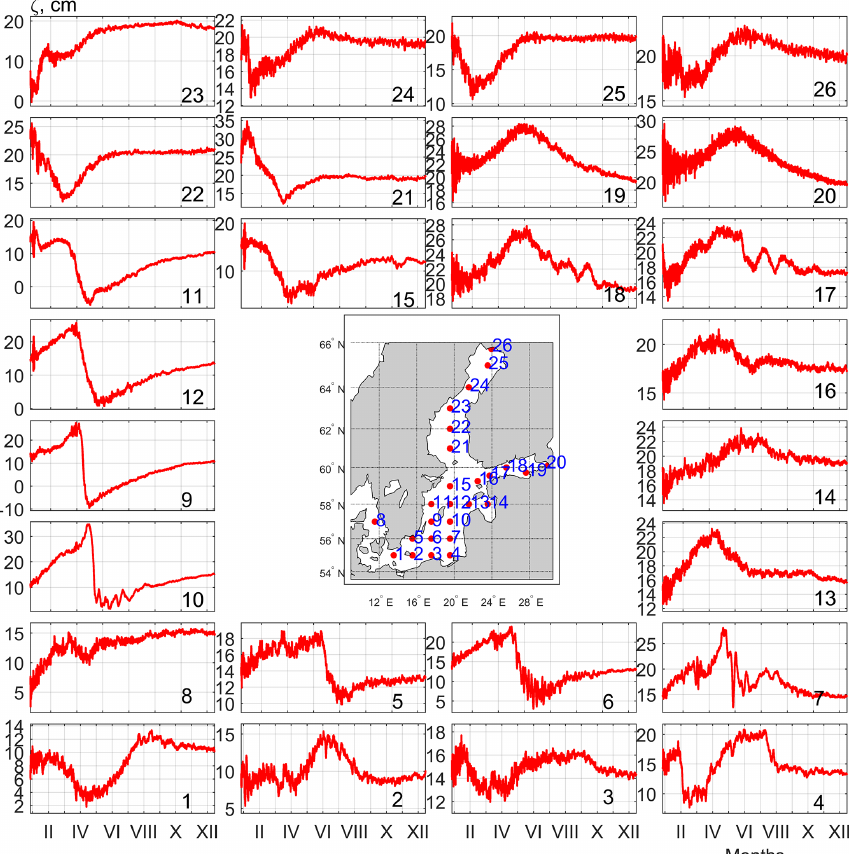
Figure 9. Time series of free sea level oscillations in baroclinic conditions at selected points simulated by INMOM. Locations of points are shown on the map.